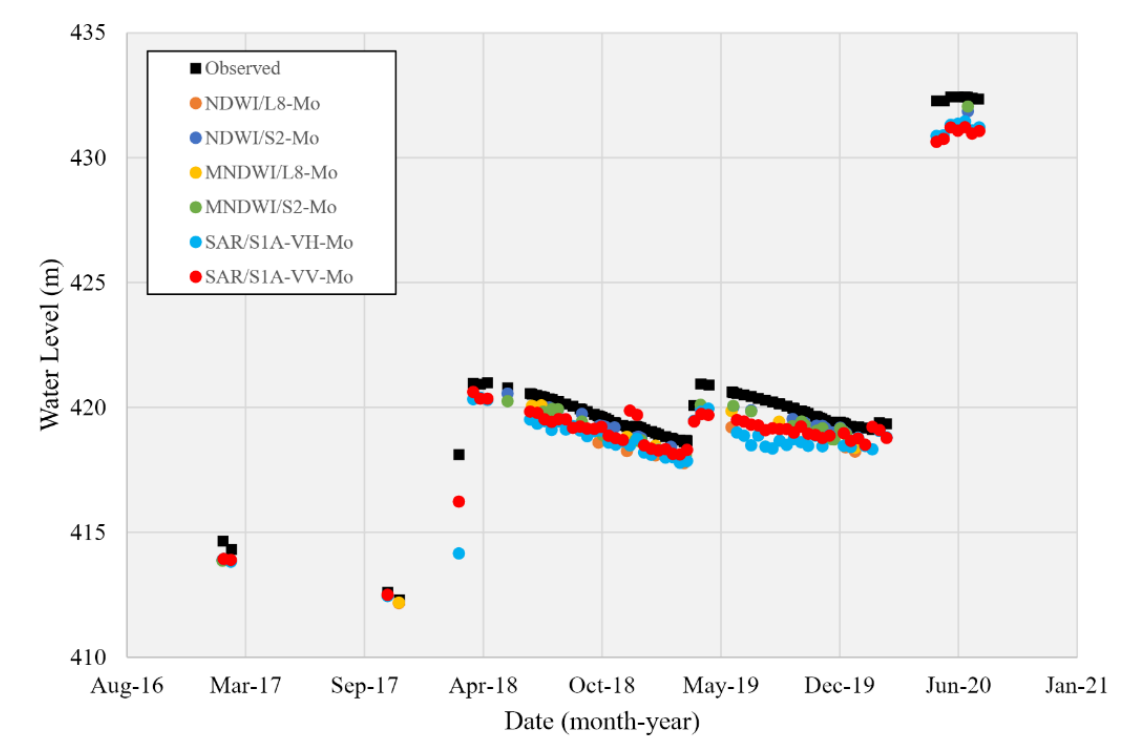
Figure 15. Comparison between reconstructed and observed time series water levels using remote sensing.